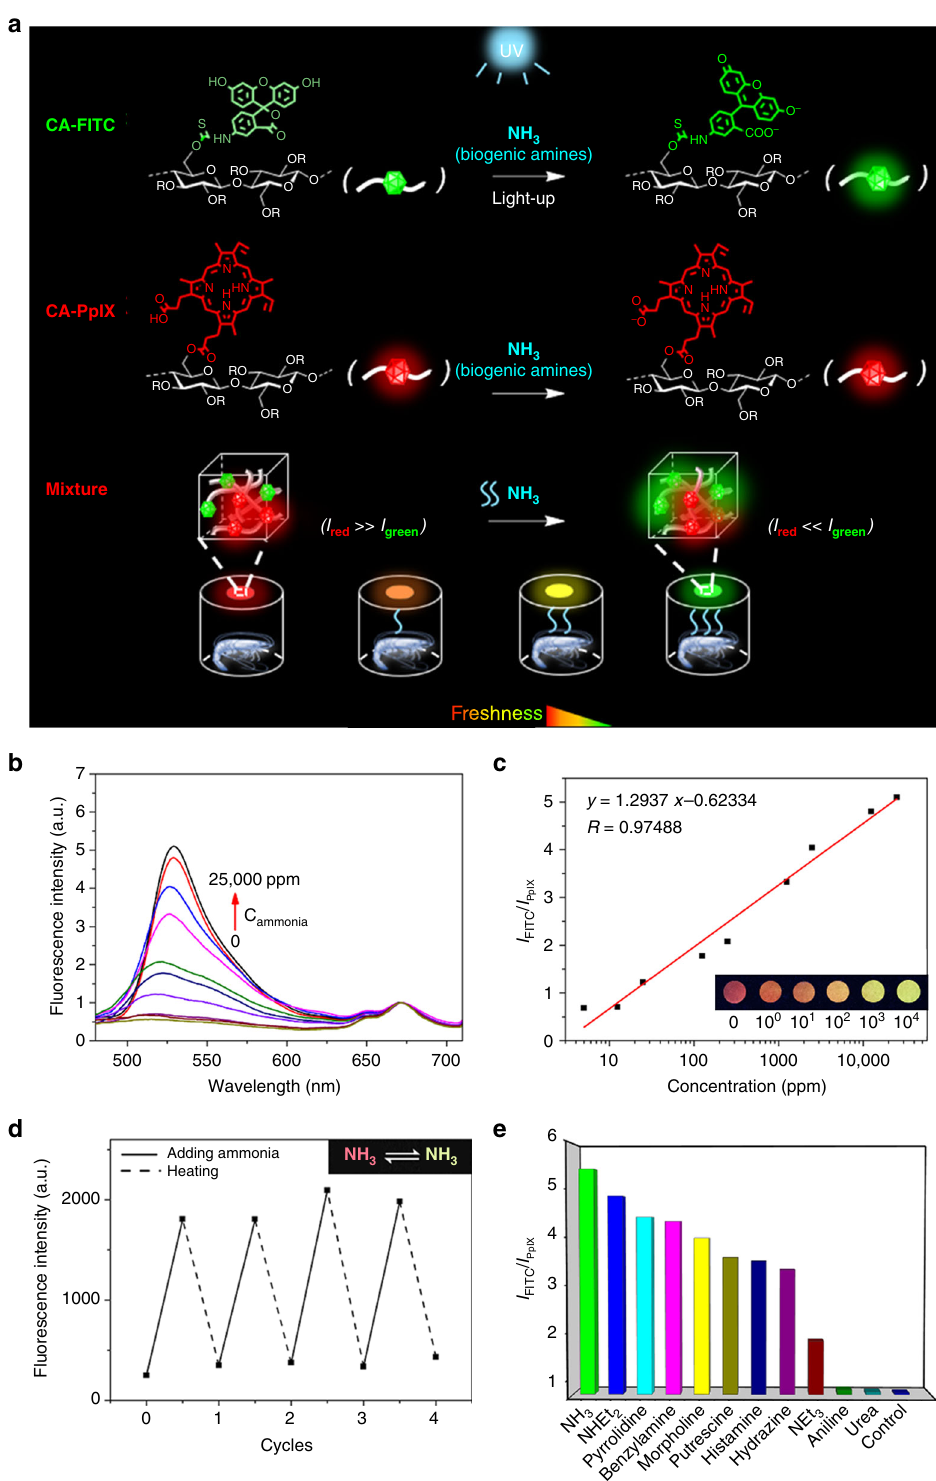
Fig. 3 Amine-response behavior of cellulose-based ratiometric fl uorescent materials. a Schematic illustration for the mechanism of the cellulose-based ratiometric fl uorescent material. b Emission spectra of the nano fi brous membrane dipping in different concentrations of ammonia. c Plot of the fl uorescence intensity ratio of CA-FITC to CA-PpIX ( I I fl uorescence images of the membrane treated with FITC / PpIX ) versus concentration of ammonia. Inset: a series of different concentrations of ammonia. d Fluorescence enhancement and quenching cycles of the emission peak at λ em = 525 nm upon the nano fi brous membrane dipping in 2500 ppm ammonia and following heated. Inset: reversible color change of the nano fi brous membrane in a cycle. e Fluorescence response of the nano fi brous membrane to ammonia and other organic amines in water (2500 ppm). Excitation wavelength, 365 nm